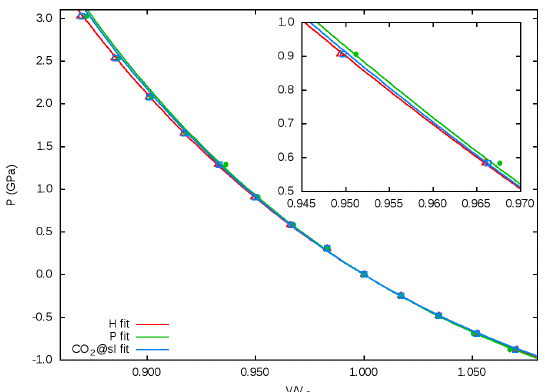
Figure 3. Vinet EOS and data points for the unit cell, P and H cages. The corresponding normalized volumes, V / V 0 , with respect to pressure, p , are